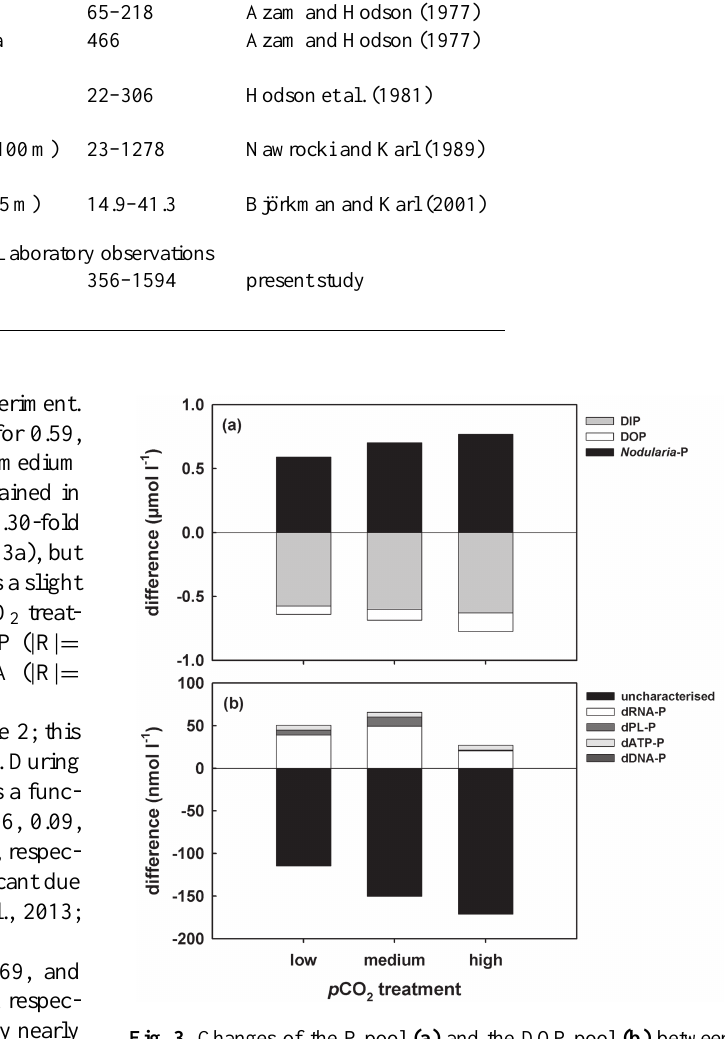
day 15 the dATP-P concentration was reduced by 3.2 (low p CO 2 ) , 2.8 (medium p CO 2 ) , and 3.0 (high p CO 2 ) nmol l − 1 (Fig. 4e), without significant differences between